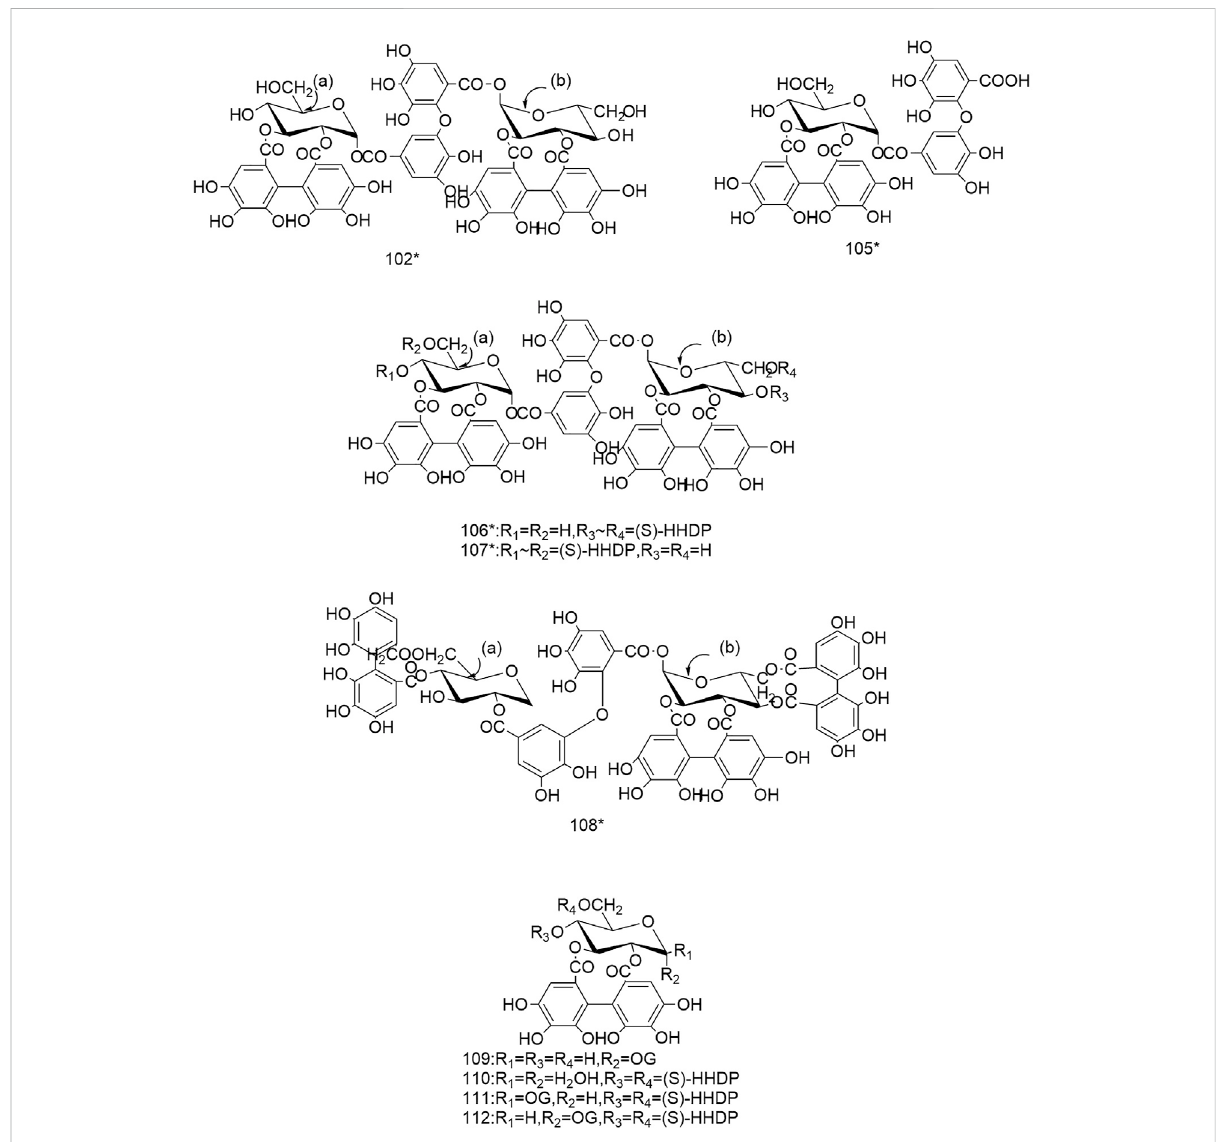
FIGURE 4 Diagrammatic representation of the structural formulas of tannins of compounds found in R. laevigata Michx.